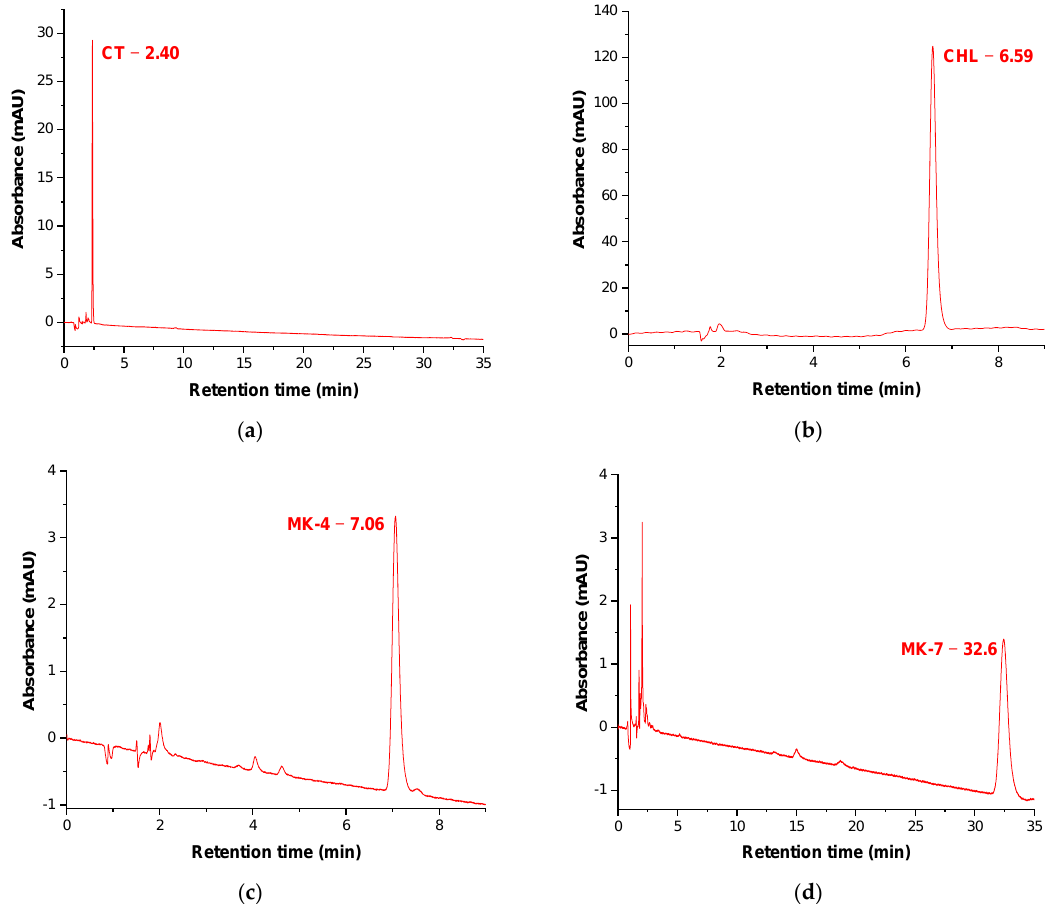
Figure 1. HPLC chromatograms of the analyzed D3 and K2 vitamins: ( a ) calcitriol, CT; ( b ) cholecalciferol, CHL; ( c ) menaquinone-4, MK-4; ( d ) menaquinone-7, MK-7.